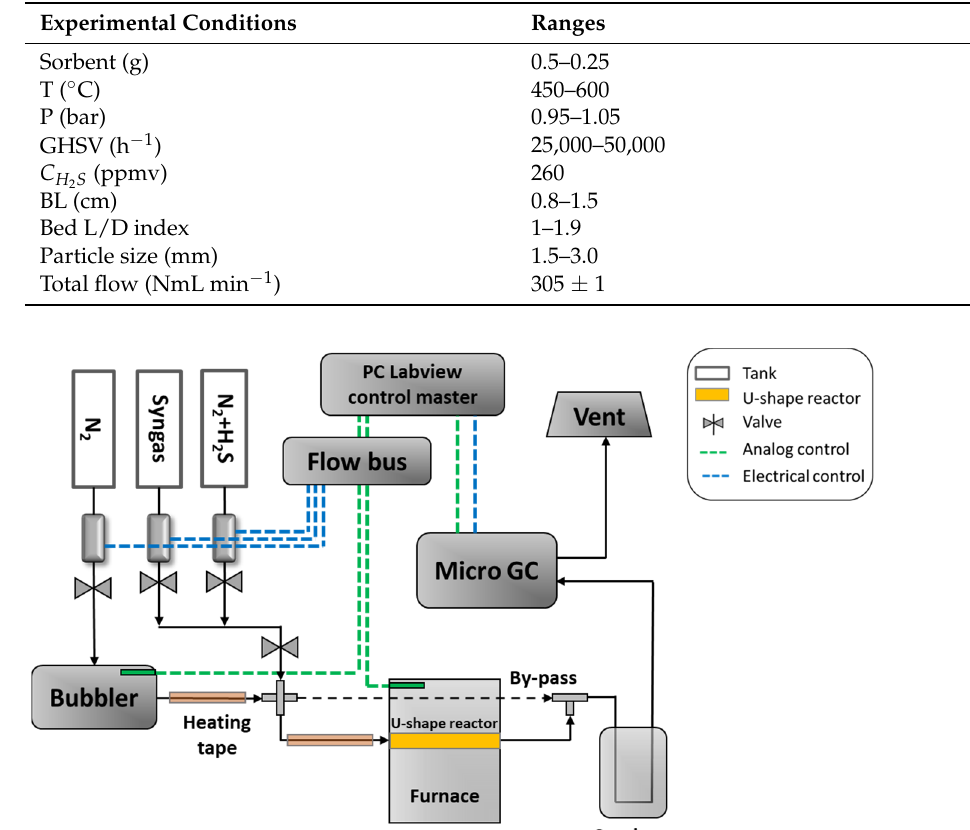
Figure 1. The layout of the experimental setup for the adsorption analysis.